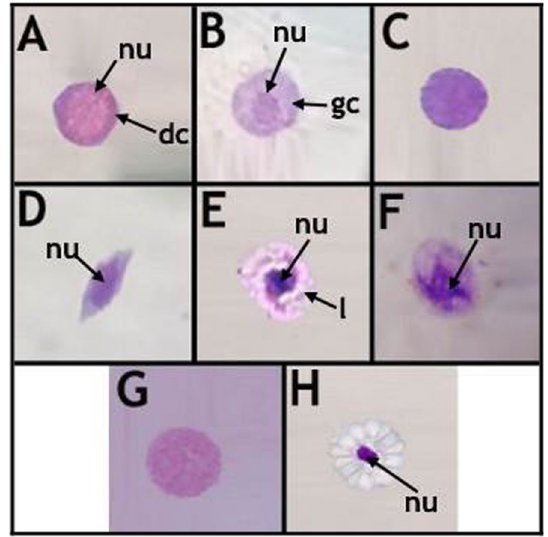
Fig. 5 Normal haemocytes of 5th instar larvae Agrotis ipsilon ( x 1600). A Prohaemocytes, B Plasmatocytes, C Granulated cells, = D Spindle cells, E Adipohaemocytes, F Oenocytoids, G Spherule cells, H Cystocytes. nu: haemocyte nucleus, dc: dense chromatin in cytoplasm, gc: granular chromatin in cytoplasm, l: lipids droplets